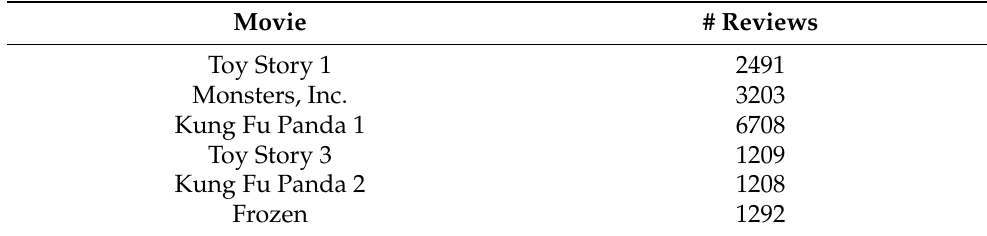
Table 1. Amazon movie review corpus grouped by movie and number of reviews per slice of input